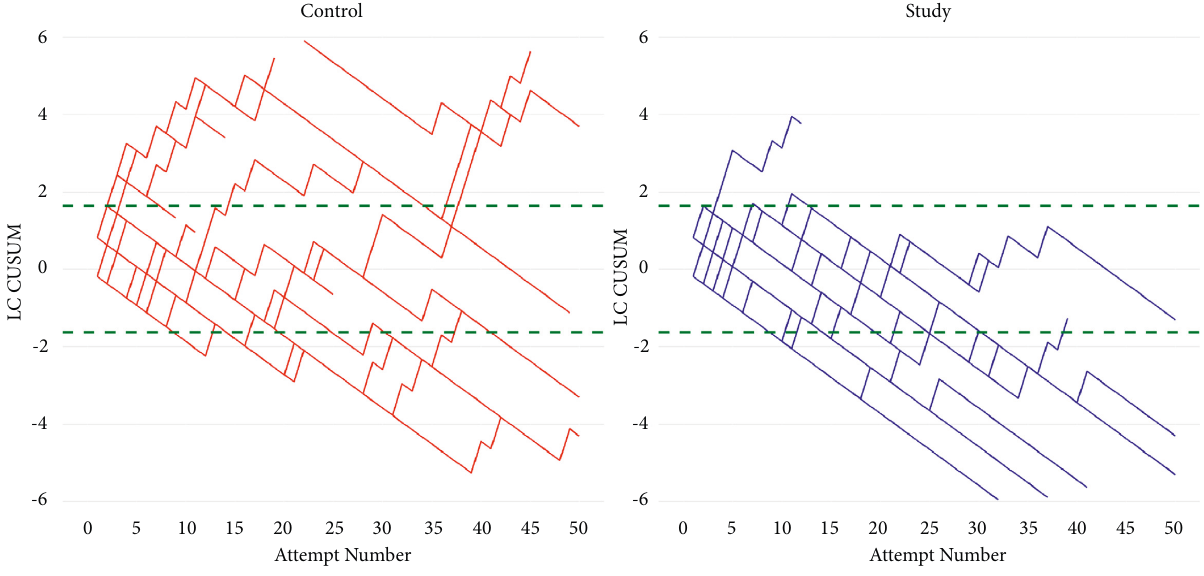
Figure 1: CUSUM curves of subjects in the control and study groups. Table 1: Effects of changing the levels of accepted and unaccepted failure rate on the frequency distributions of the trainees who recorded an improvement in performance with CUSUM and on the mean number ( ± SD) of epidurals carried out to achieve the improvement. Failure